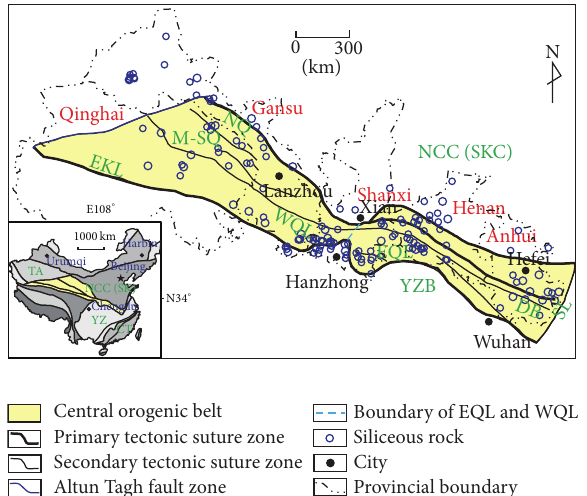
Figure 7: Spatial distribution of total siliceous rocks in the COB (EKL: eastern Kunlun; M-SQ: Middle-South Qilian; NQ: North Qilian; WQL: Western Qinling; EQL: Eastern Qinling; SKC: Sino- Korean craton; YZB: Yangtze block; DB: Dabie orogenic belt; Data sources: [32,